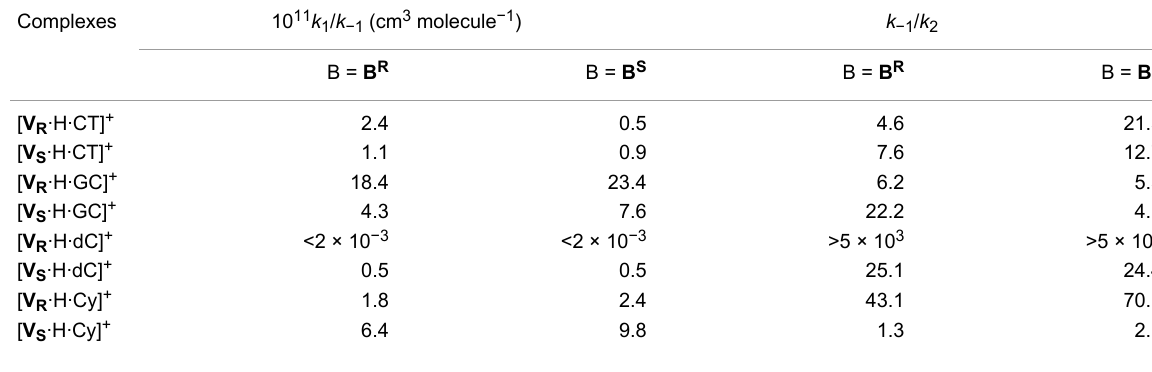
Table 3: Rate constant ratios (Equation 6).